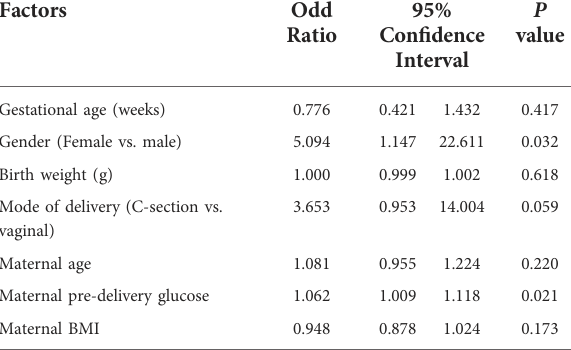
Point of care glucose vs. plasma glucose levels Thirty of sixty- fi ve subjects (46%) had their blood redrawn for laboratory plasma glucose levels within 1 – 2 min of POC glucose levels <40 mg/dl (2.22 mmol/L). We found the median paired difference between the POC glucose and the plasma glucose was 0.05 mmol/L (interquartile ranges, 1.51 – 2.07; 1.43 – 2.19 mmol/L respectively, p = 0.81), as shown in Figure 2 . Nevertheless, 20% (6 of 30) of the subjects with POC glucose <40 mg/dl (2.22 mmol/L) had plasma glucose levels >40 mg/dl (2.22 mmol/L) but <47 mg/dl (2.61 mmol/L), and another 6.7% (2 of 30) had a plasma glucose level of ≥ 47 mg/dl (2.61 mmol/L).